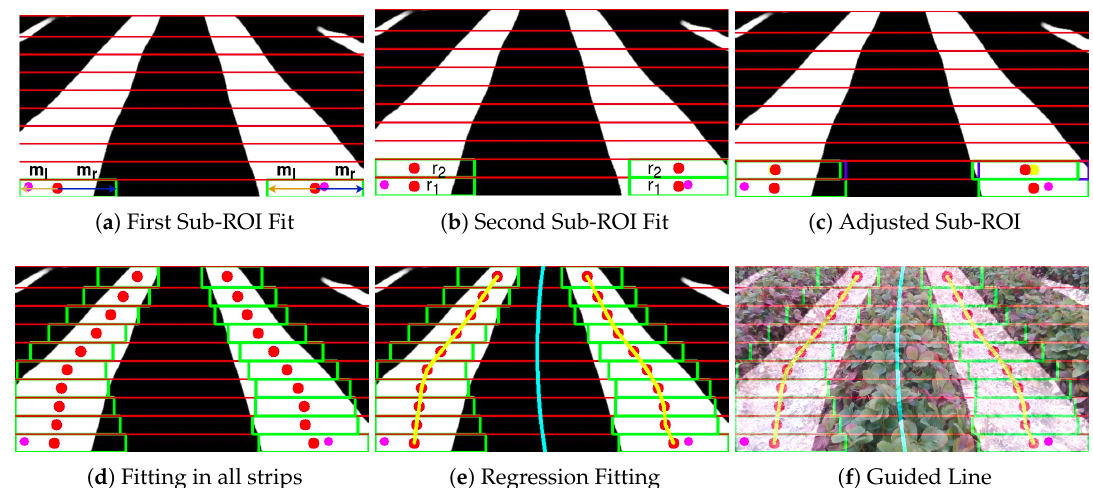
Figure 5. Step by Step Procedure for fitting multiple windows over the pixels of interest as ( a ) Window applies over peaks and adjusted based on mean values of the white pixels. ( b ) The neighboring strip has a second window with the same center as the previous window. ( c ) Second window adjusted with the mean of white pixels within its boundaries. ( d ) The same method extends until the last horizontal strip. ( e , f ) Estimating the centerline for crop row guidance using regression analysis.